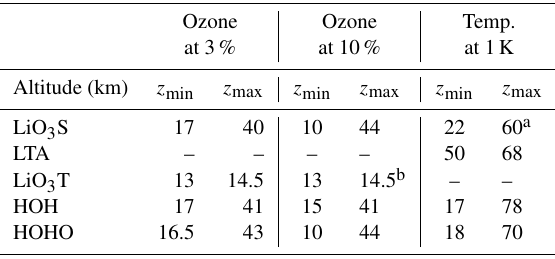
Table 1. Summary of the altitude ranges over which participating OHP and DWD lidars meet NDACC accuracy requirements at the 2 σ confidence level with respect to the travelling standard NASA- STROZ lidar. Ozone Ozone Temp. at 3% at 10% at 1K Altitude (km) z